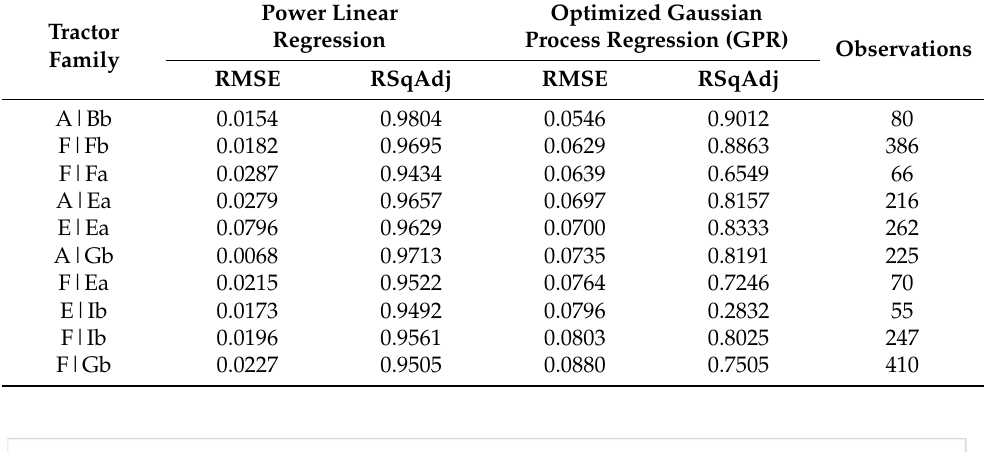
Table 11. Regression results for tractor families using two predictors.